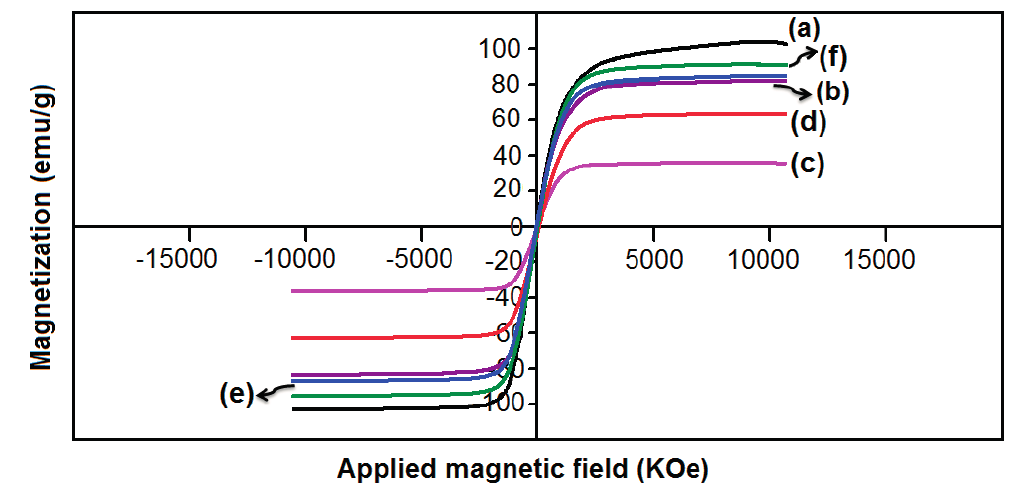
Figure 5. Magnetization curve of Fe 3 O 4 -NPs (a), RS/Fe 3 O 4 -NCs (b), and ORS/Fe 3 O 4 /PCL-NCs with 5.0, 15.0, 30.0 and 60.0 wt. % ORS/Fe 3 O 4 -NCs